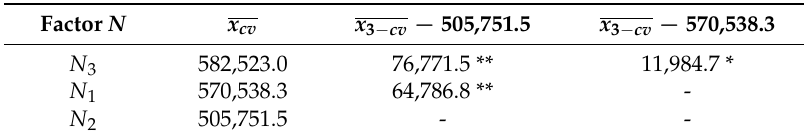
Table 9. Multiple comparison of factor N .